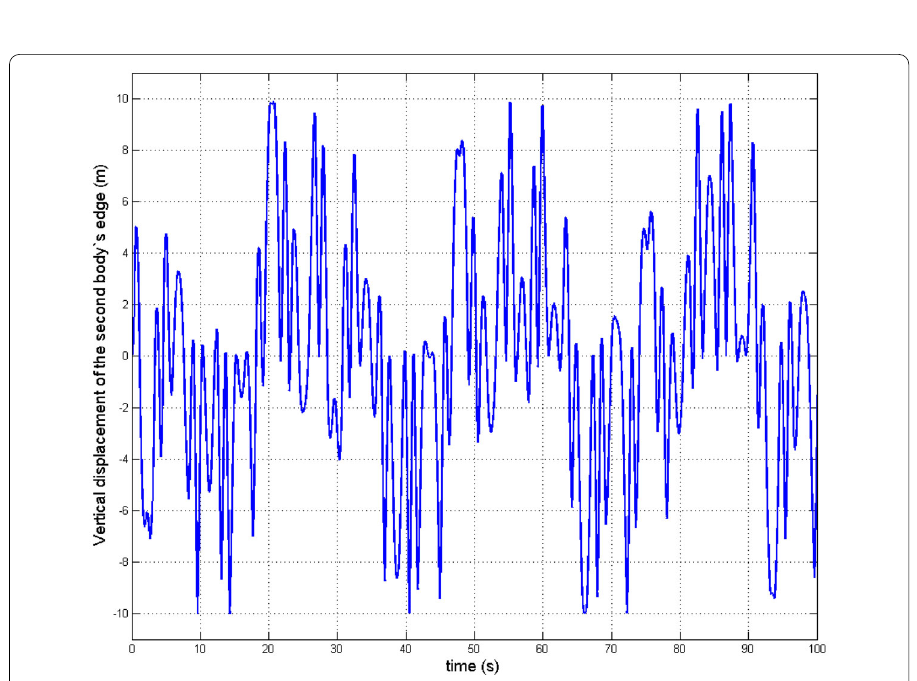
Fig. 14 Vertical displacement versus